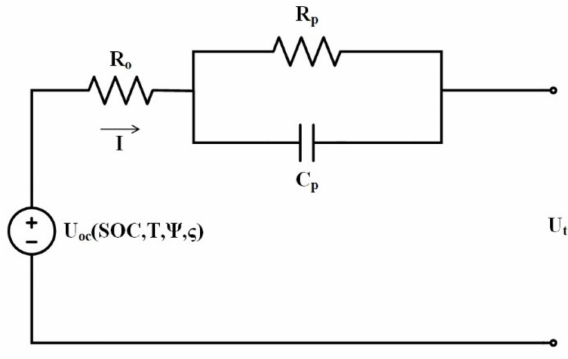
Figure 11. 1-RC model with multi-dependent OCV